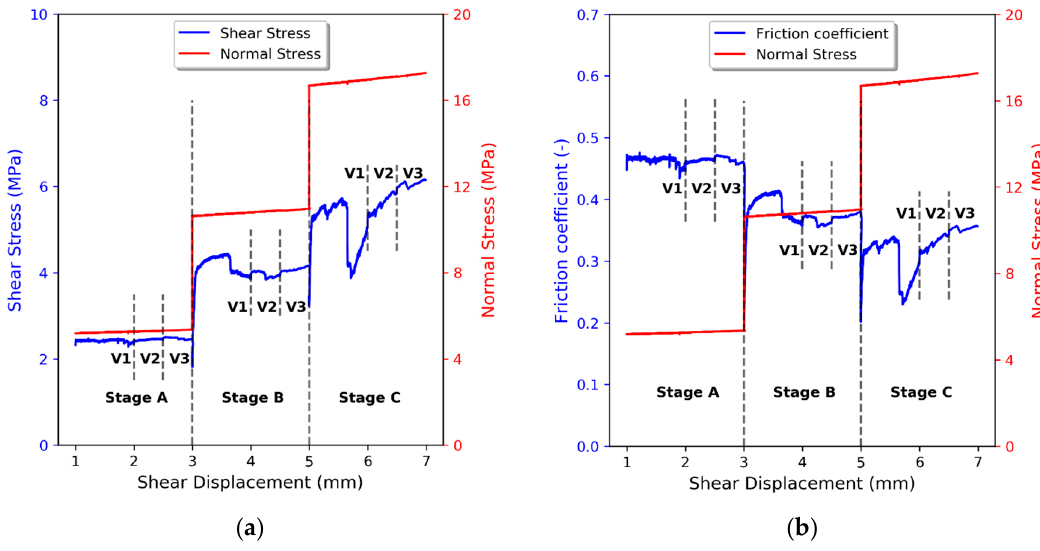
Figure 12. Results of the velocity-stepping direct shear tests on a laboratory-induced, bedding-parallel fracture for Rurikfjellet shale specimen LYB22. Evolution of shear stress ( a ) and friction coefficient ( b ) versus shear displacement at different normal stresses and at various shear velocities.